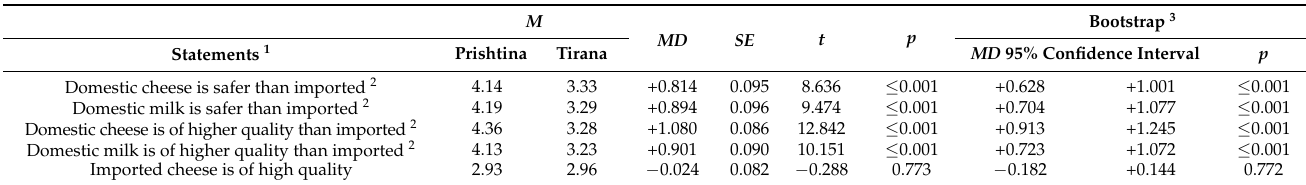
Table 2. Differences in the assessment of domestic in comparison to imported dairy food in Kosovo (Prishtina) and Albania (Tirana) ( n = 649); unpaired two sample t -test including bootstrap sampling.